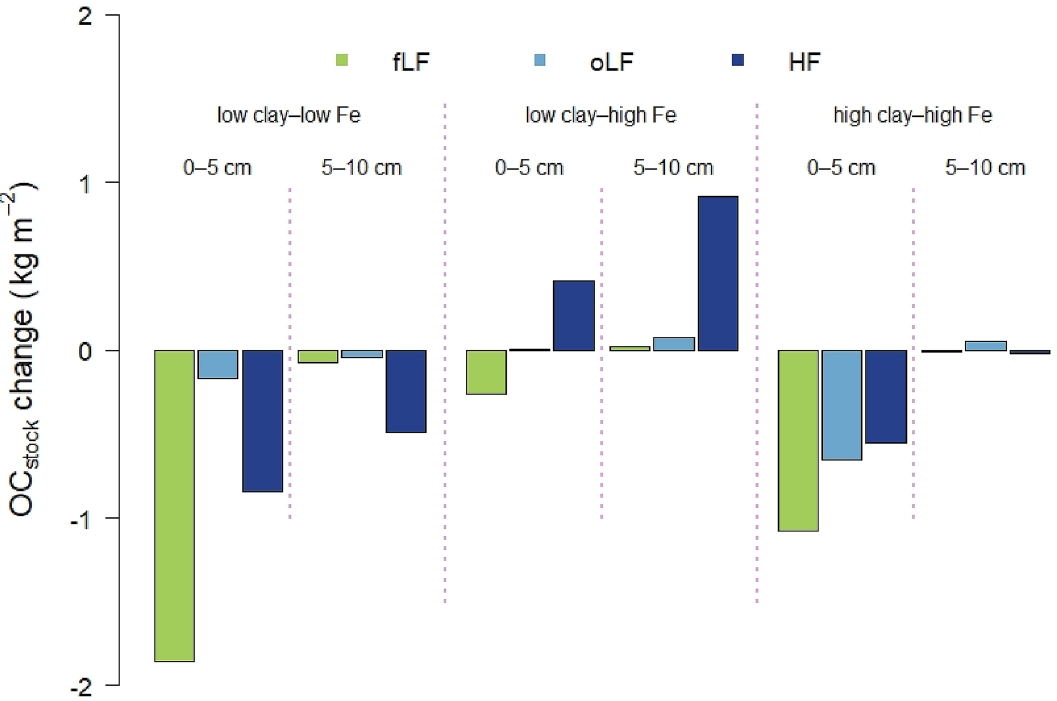
Figure 4. Changes of OC stocks associated with soil density fractions (fLF and oLF = free and occluded light fraction; HF = heavy fraction) in mineralogical combinations and separated by soil depth. Sample numbers for the combinations are as follows: ‛ low clay ‒ low Fe’ under forest ( n = 4), ‛ low clay ‒ high Fe’ under forest ( n = 4), ‛ high clay ‒ low Fe’ under forest ( n = 3), ‛ high clay ‒ high Fe’ under forest ( n = 7); all cropland combinations ( n =